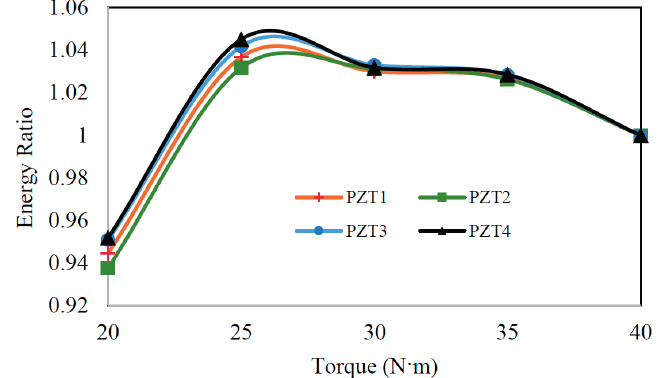
Figure 11. The normalized energy as a function of the clamp torque level.